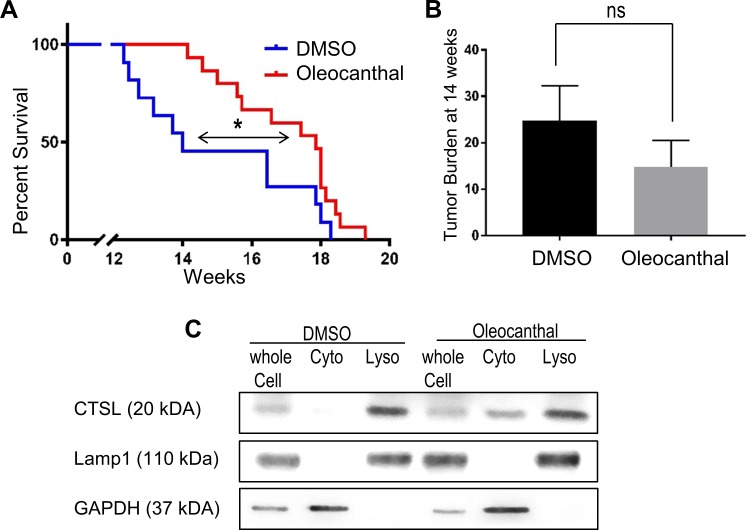
Oleocanthal increases life span of mice with PNET tumors.(A) Kaplan-Meier survival curve for RIP-Tag mice receiving DMSO or oleocanthal. The mice were treated with DMSO (n = 11) or oleocanthal (5 mg/kg, n = 15), 7 days a week. Mice were treated starting from 9 weeks of age. Both the Gehan-Breslow-Wilcoxon method and the Log-rank (Mantel-Cox) method were used to calculate statistical significance *P < 0.05. (B) Tumor burden from mice treated with DMSO or oleocanthal (n = 7 for each group) starting from 9 weeks of age and ending at 14 weeks of age. ns P > 0.05. (C) A cell-line derived from a murine PNET tumor, was established (N134). Cells were treated with DMSO or oleocanthal and analyzed for cytosolic cathepsin L (CTSL) via Western blot as in Fig 2C.